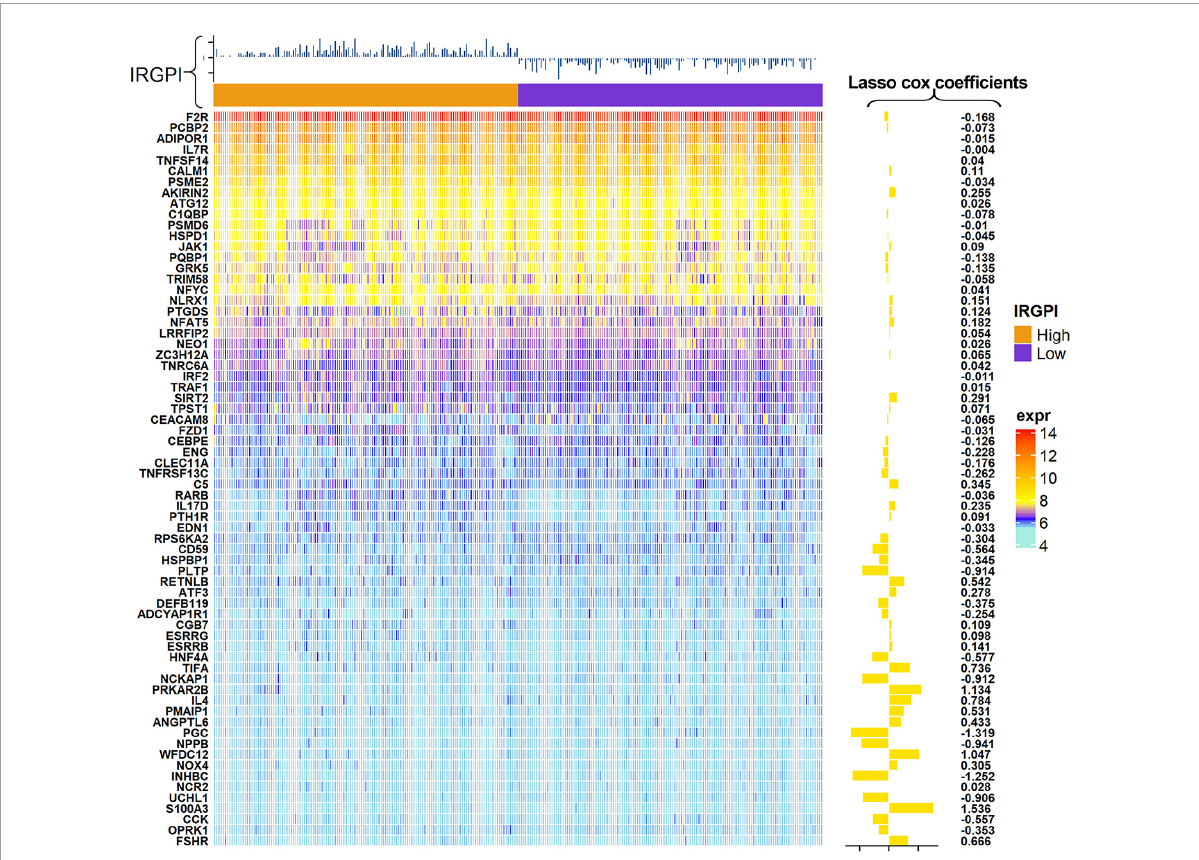
FIGURE2 Heatmap showed the landscape of expression levels of the immune-related gene prognostic index (IRGPI) signature and the LASSO COX